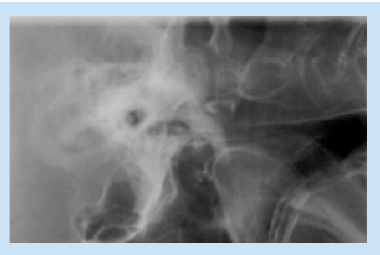
Fig. 2b. Prone lateral study. The contrast in the sphenoidal sinus has emptied via the same channel, into the nasal cavity leaving a thin mucosal coating in the sinus. Fig 3a. Lateral erect study revealing failure of